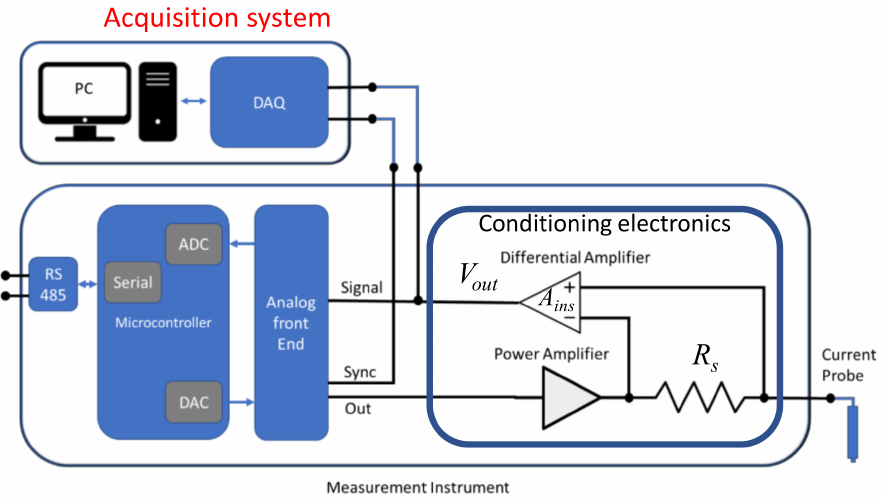
Figure 4. Conditioning electronics and measurement